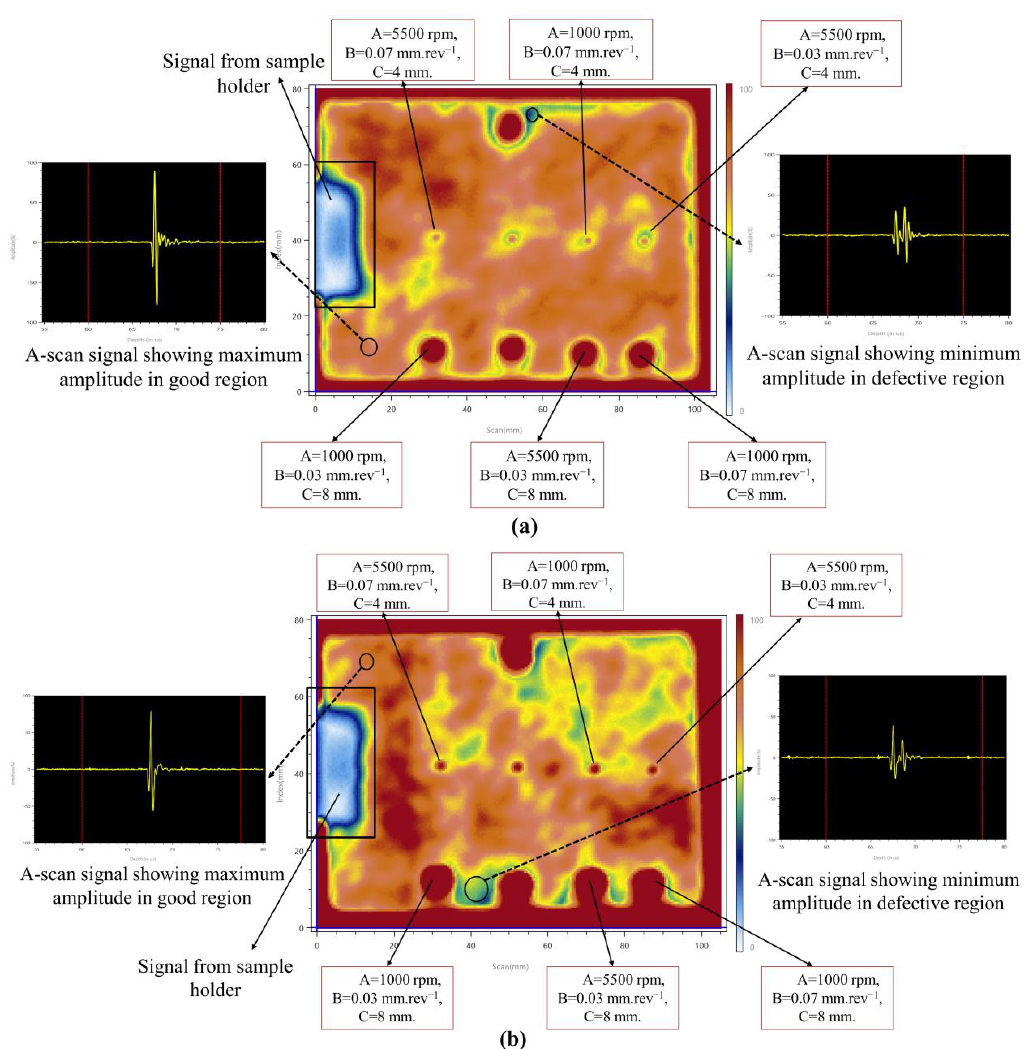
Figure 12. Through-transmission C-scan images of ( a ) 4MoS 2 -CEC and ( b ) 4BN-CEC.